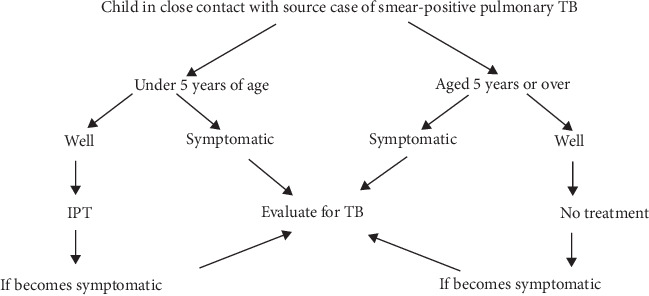
Approach contact management of children in Ethiopia.